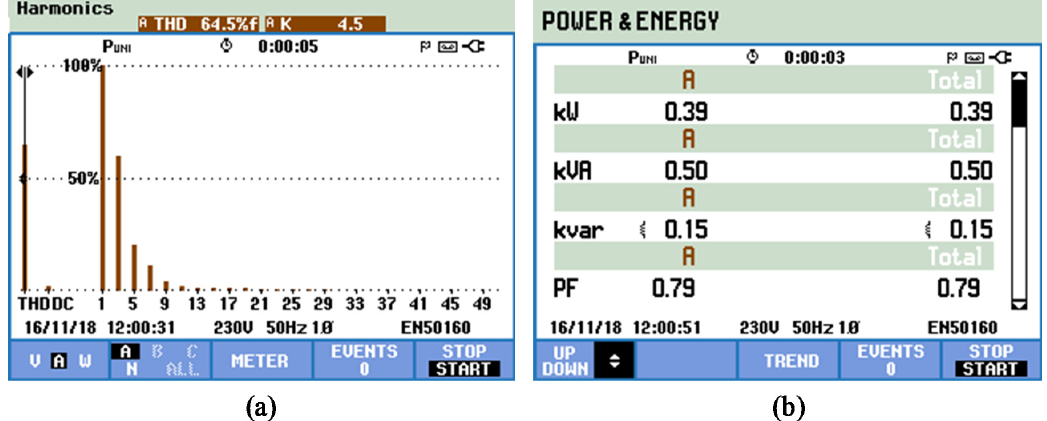
Figure 7. Experimental results without the operation of the MF-EVCS (in G2V mode): ( a ) Harmonic spectrum of the electrical appliances current ( i ea ); ( b ) Operating powers and total power factor.